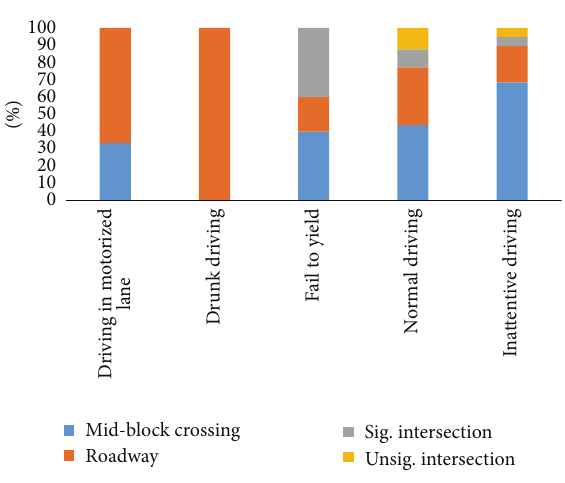
Figure 8: Breakdown of crash locations for precrash behaviors of drivers.